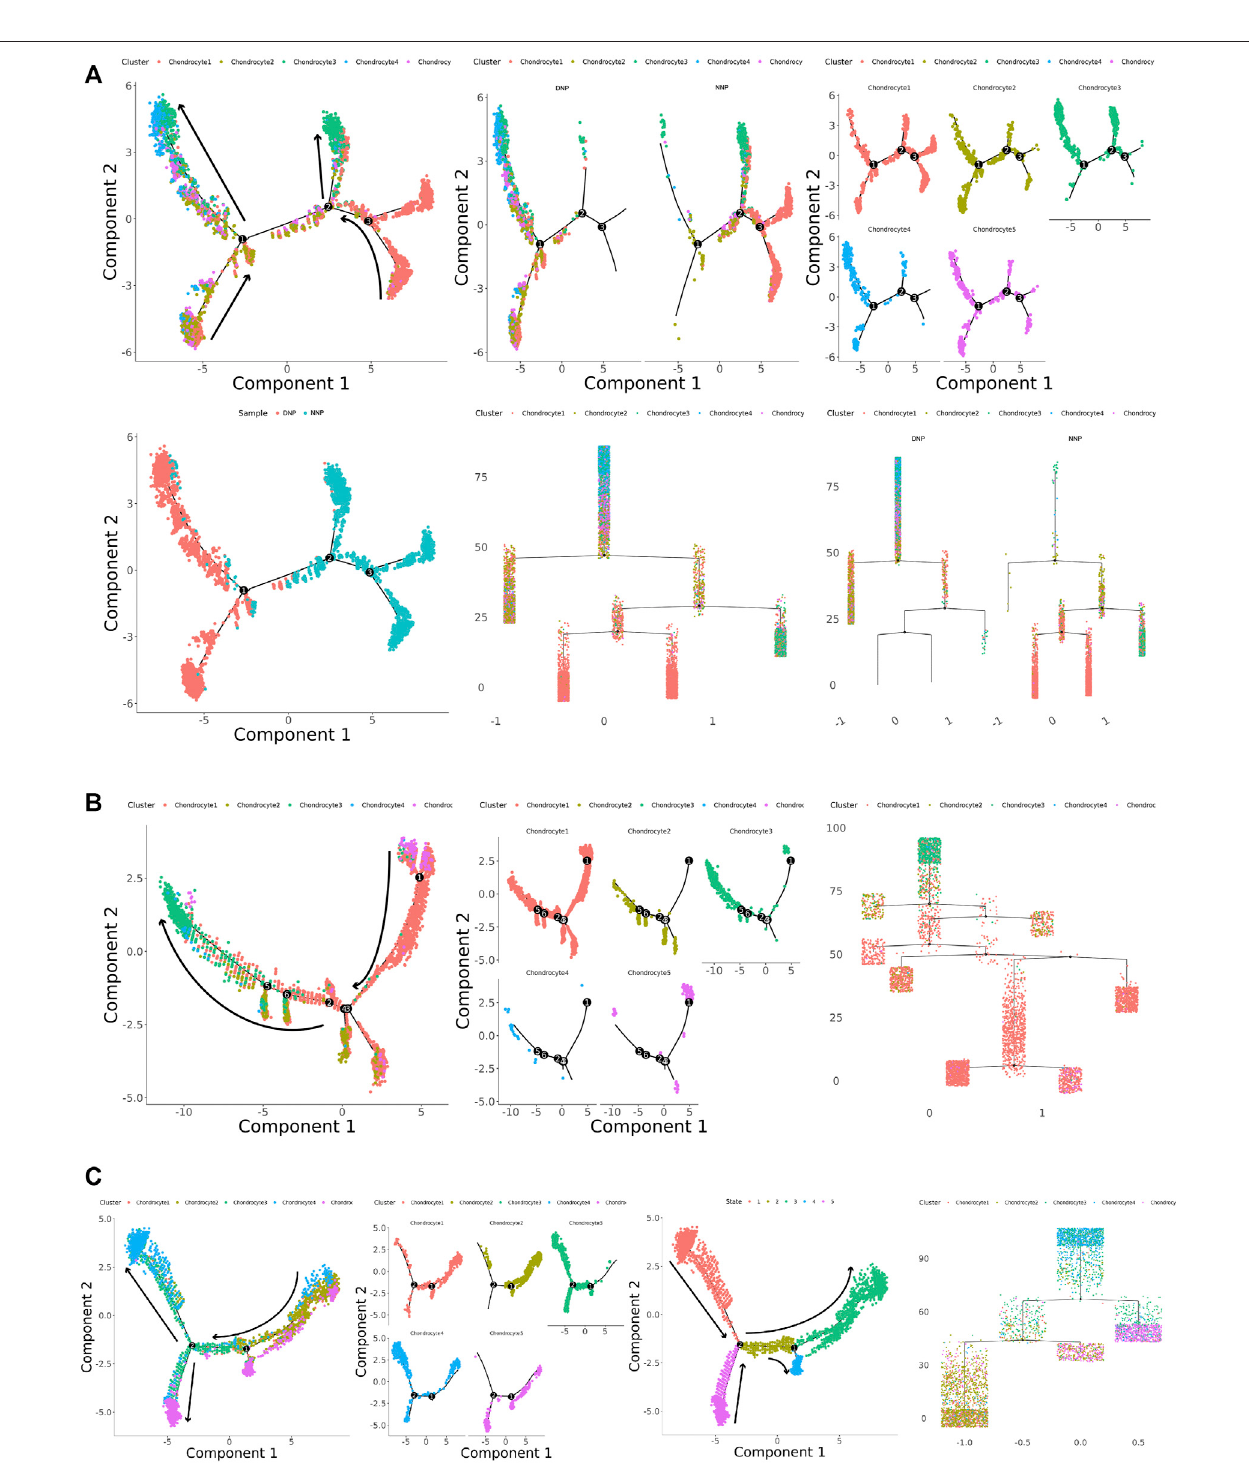
FIGURE 5 | Monocle pseudo-time trajectory. (A) Monocle pseudo-time trajectory showing the progression of chondrocyte 1, chondrocyte 2, chondrocyte 3, chondrocyte 4, and chondrocyte 5 in nucleus pulposus cells. (B) Monocle pseudo-time trajectory showing the progression of chondrocyte 1, chondrocyte 2, chondrocyte 3, chondrocyte 4, and chondrocyte 5 in NNP cells. (C) Monocle pseudo-time trajectory showing the progression of chondrocyte 1, chondrocyte 2, chondrocyte 3, chondrocyte 4, and chondrocyte 5 in DNP cells.